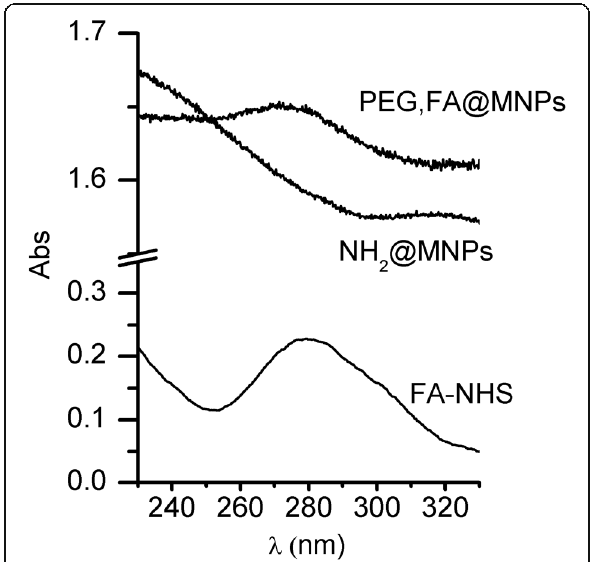
Fig. 5 UV/Vis characterization of functionalized MNPs. UV/Vis spectra of a 5 μ M FA-NHS solution and of NH 2 @MNPs, and PEG,FA@MNPs colloidal dispersions. Note that the high background observed in the spectra of NH 2 @MNPs and PEG,FA@MNPs is due to the scattering of the nanoparticle colloidal dispersion